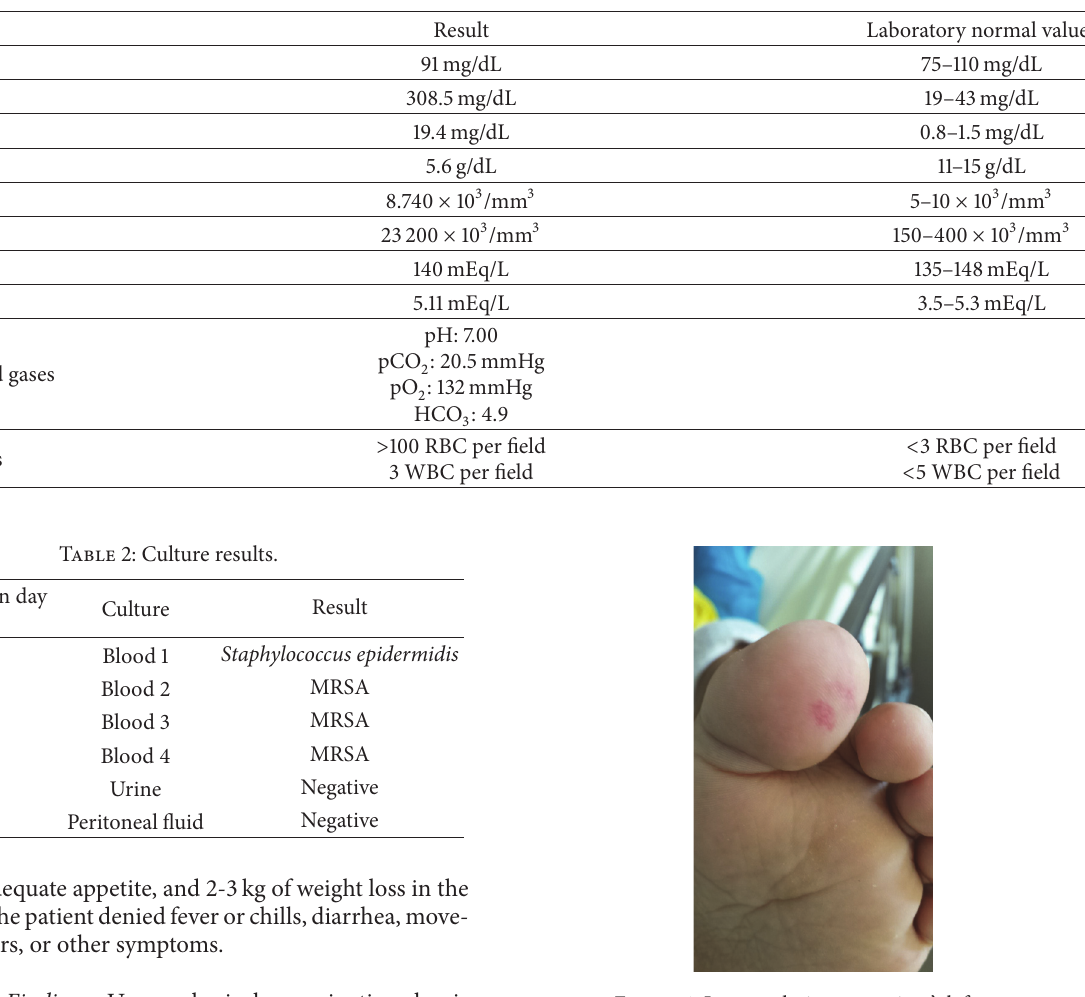
Table 1: Laboratory results.